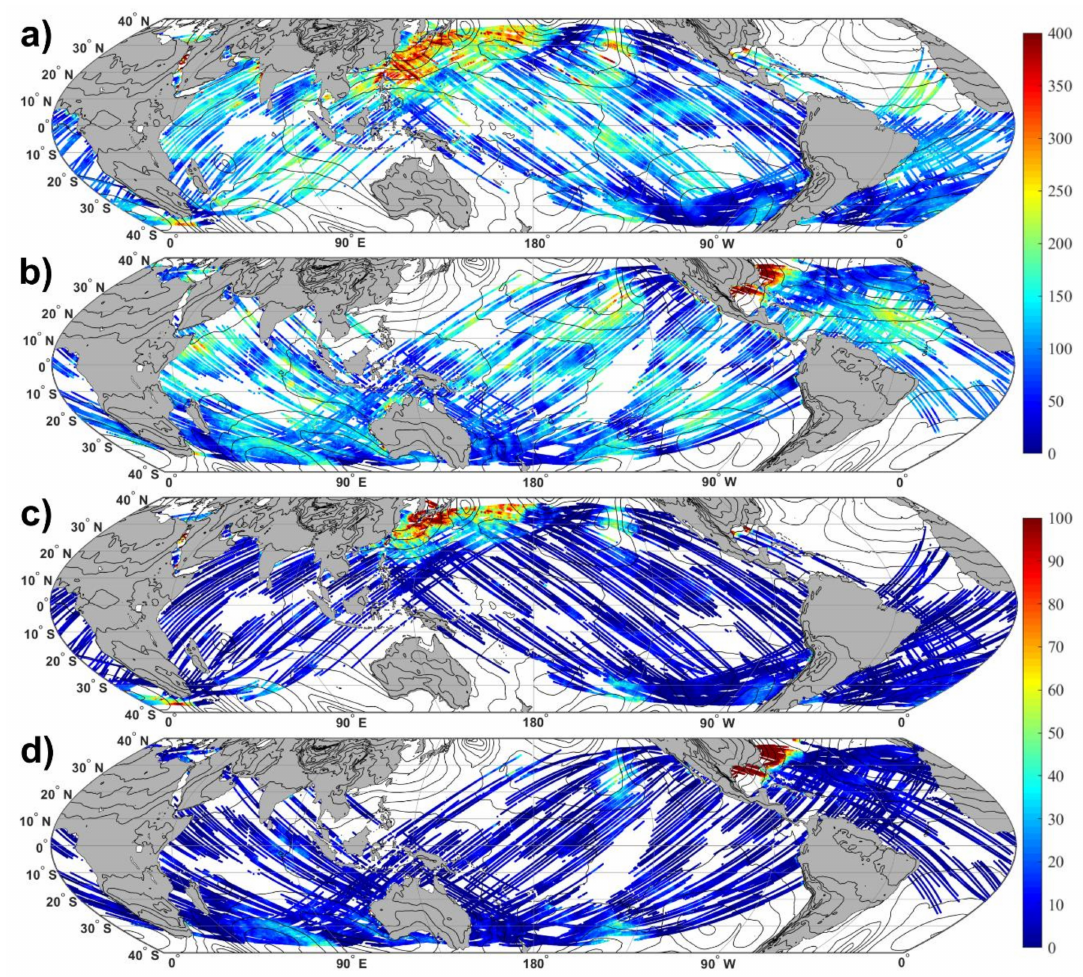
Figure 1. Full day observations of Latent ( a , c ) and Sensible ( b , d ) Heat Fluxes [W / m 2 ] from Cyclone Global Navigation Satellite System (CYGNSS) (FDS version) on 1 January 2018 from 0000–1159 UTC ( a , b ) and 1200–2359 UTC ( c , d